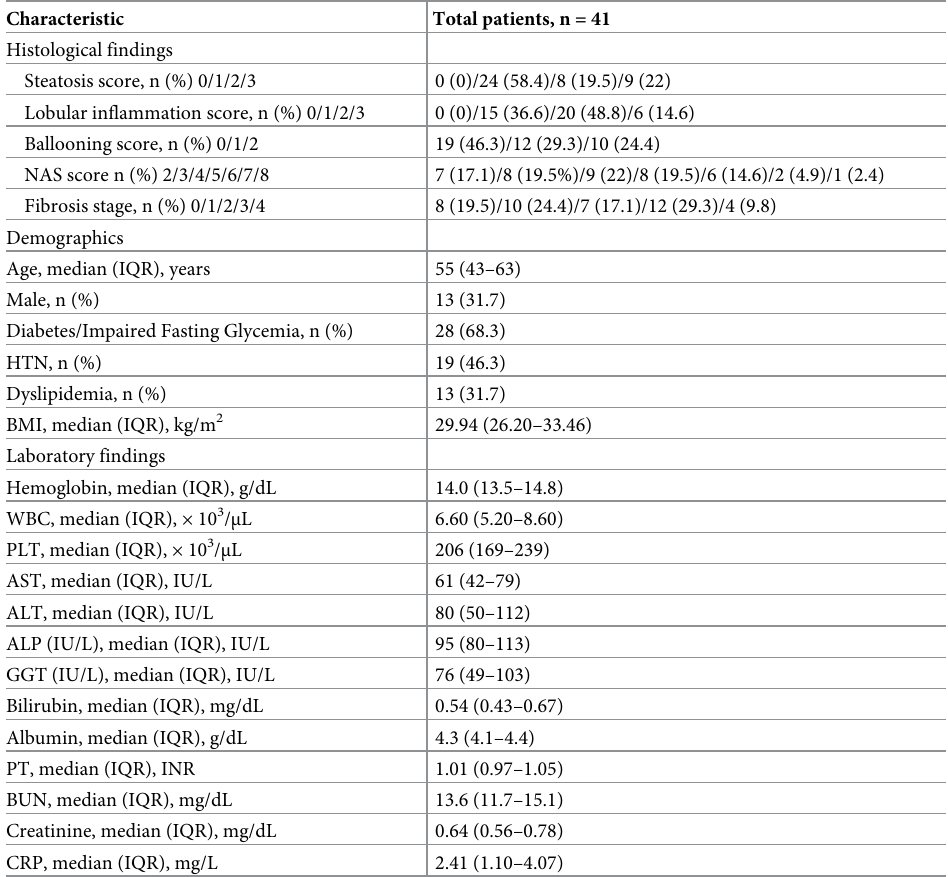
Table 1. Patient information.